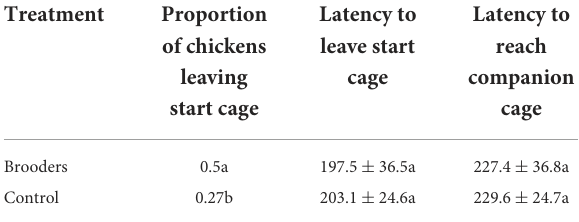
TABLE 2 Proportion of chickens leaving the start cage in a spatial learning task and latencies (s) to either leave the start cage or reach the companion